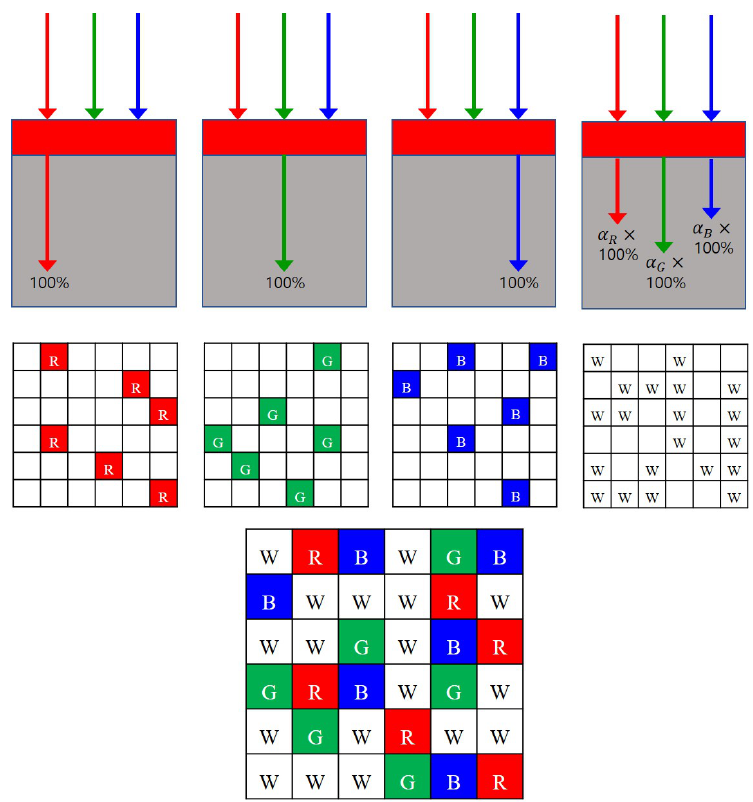
Figure 2. Proposed random RGBW CFA. R: Red pixels, G: Green pixels, B: Blue pixels, W: White